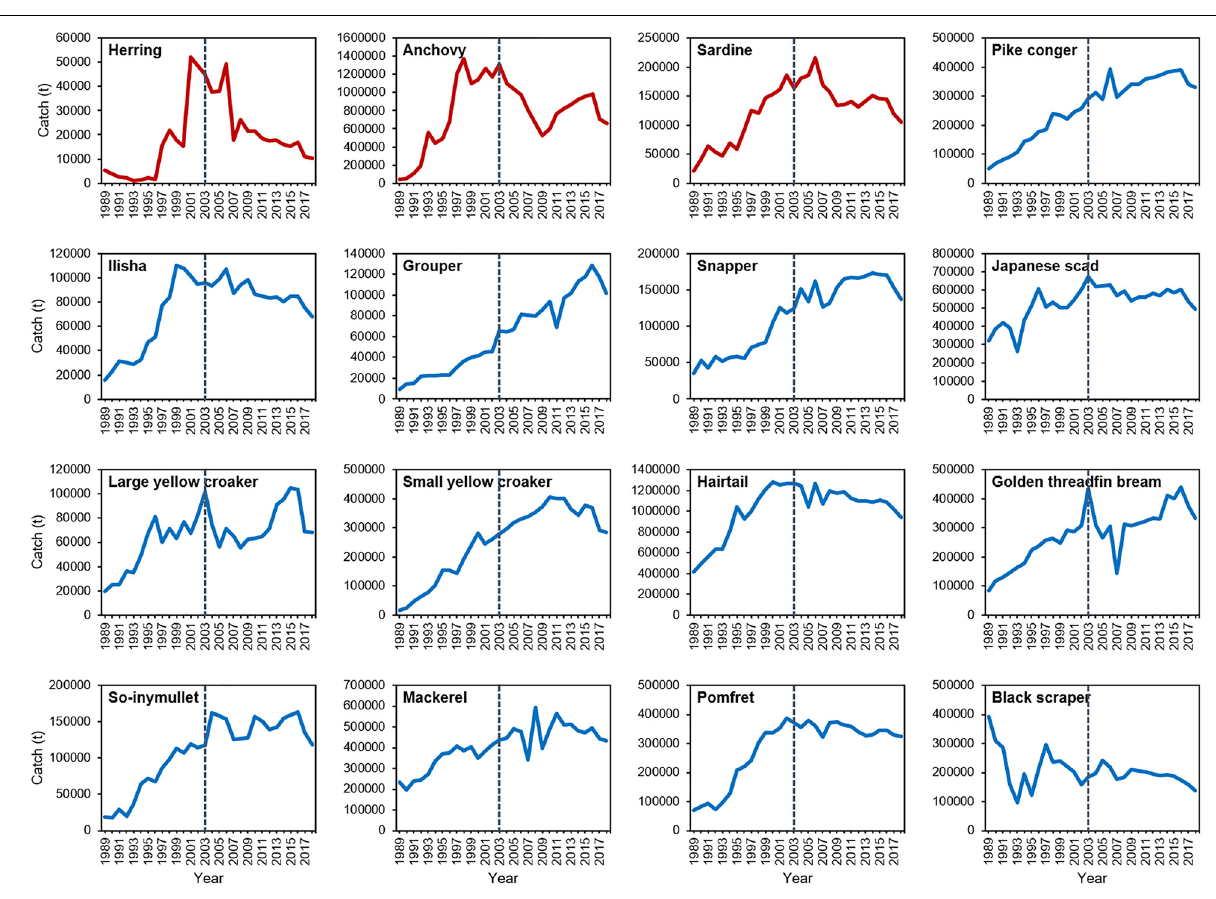
FIGURE 3 | Trends in catch of 16 species or species groups over the past 30 years in China. The trend line is red for forage fish and blue line for edible economic fish. The dotted black line is the dividing line between the two periods, located at